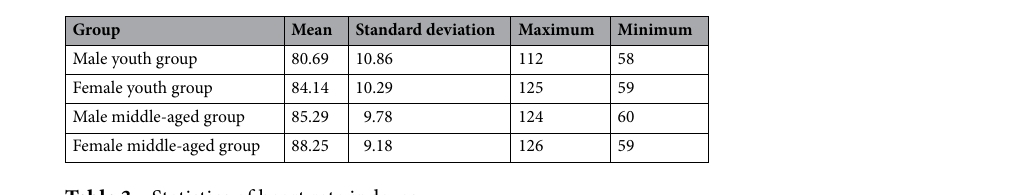
Table 3. Statistics of heart rate